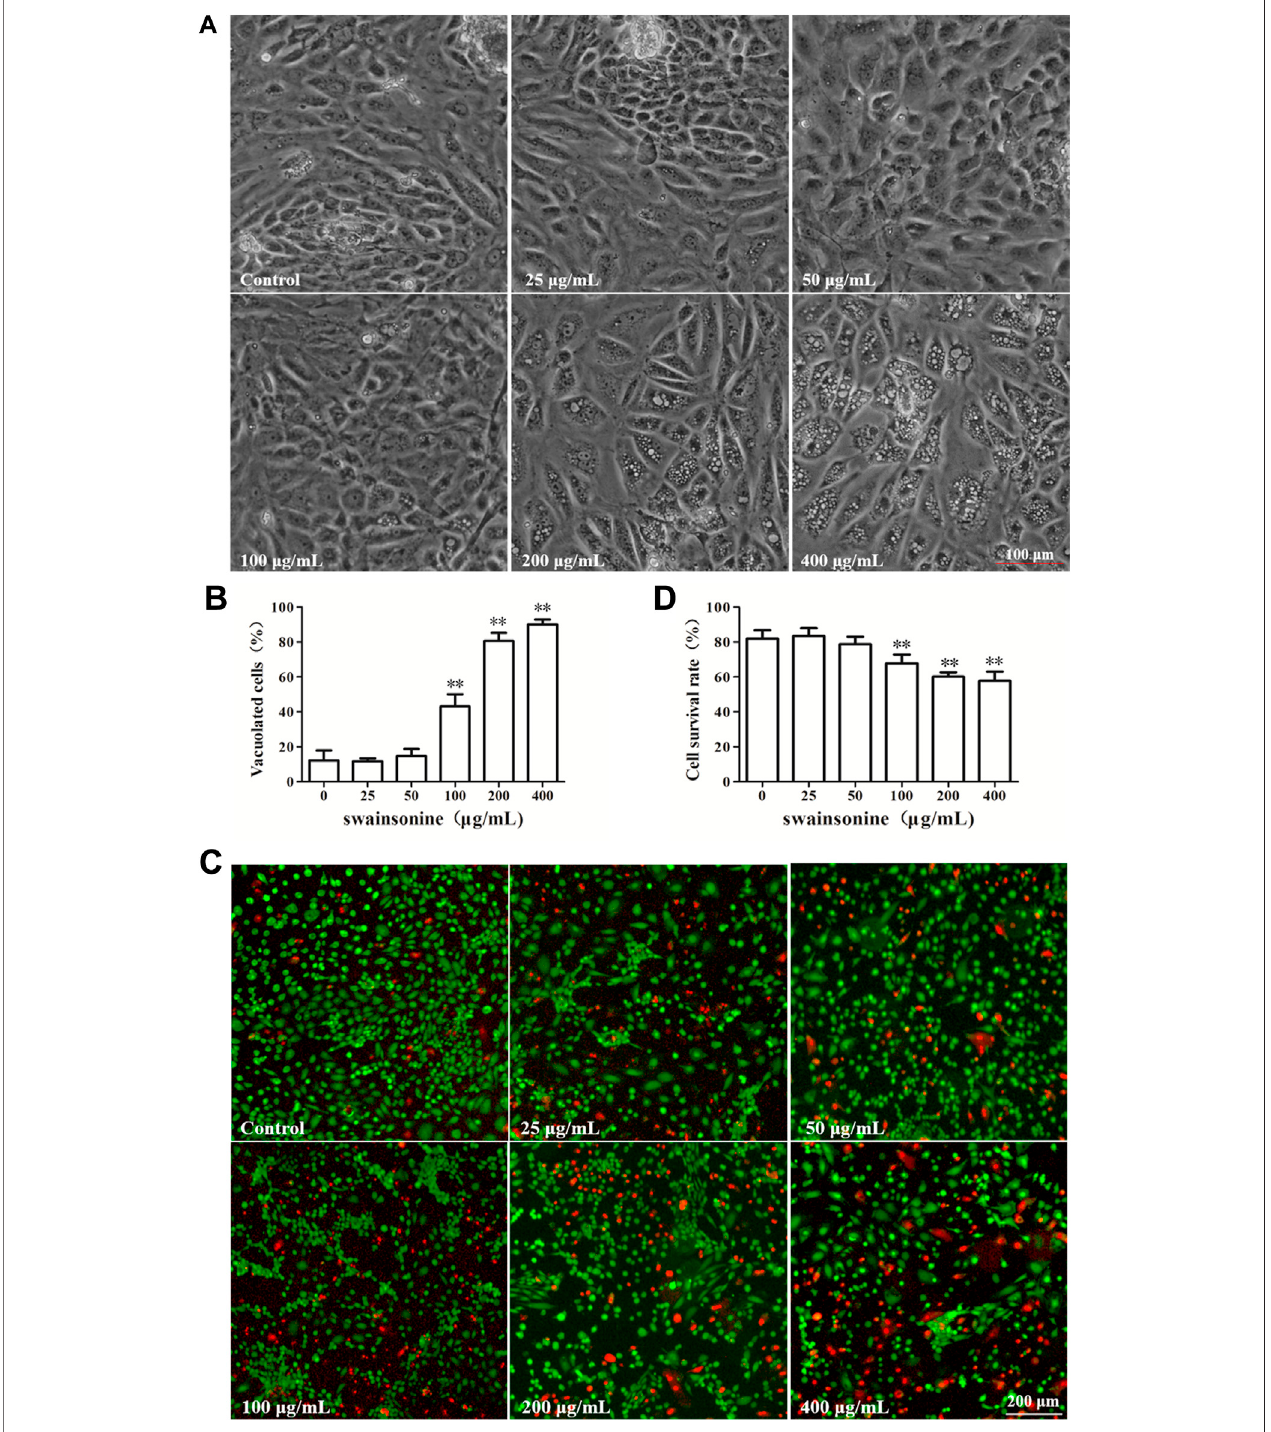
FIGURE 2 | SW induced cytoplasmic vacuolization and inhibited cell viability in RTECs (A,B) Phase-contrast images of RTECs following incubation with SW at the indicated concentrations for 24 h. Morphometric analysis ofvacuoleswasperformed with three different areas and the percentage ofSW-induced vacuolated cells was calculated (C,D) RTECs were treated with the indicated concentrations of SW for 24 h and cellular viability was measured using Live and Dead TM Viability/Cytotoxicity Assay Kit. Analyze the number of living (green spots) and dead cells (red spots) in three different areas of control and SW-treated cells and the ratios were